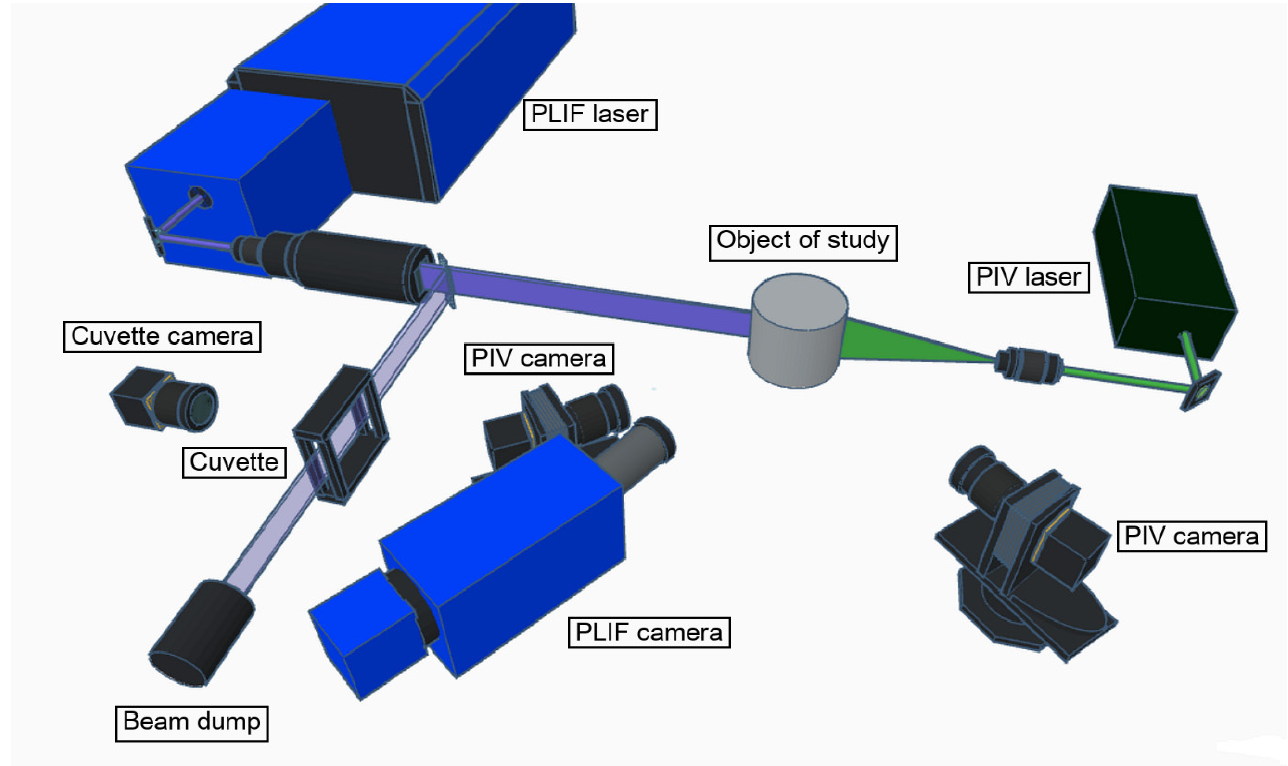
Figure 1. The scheme of the experimental setup.